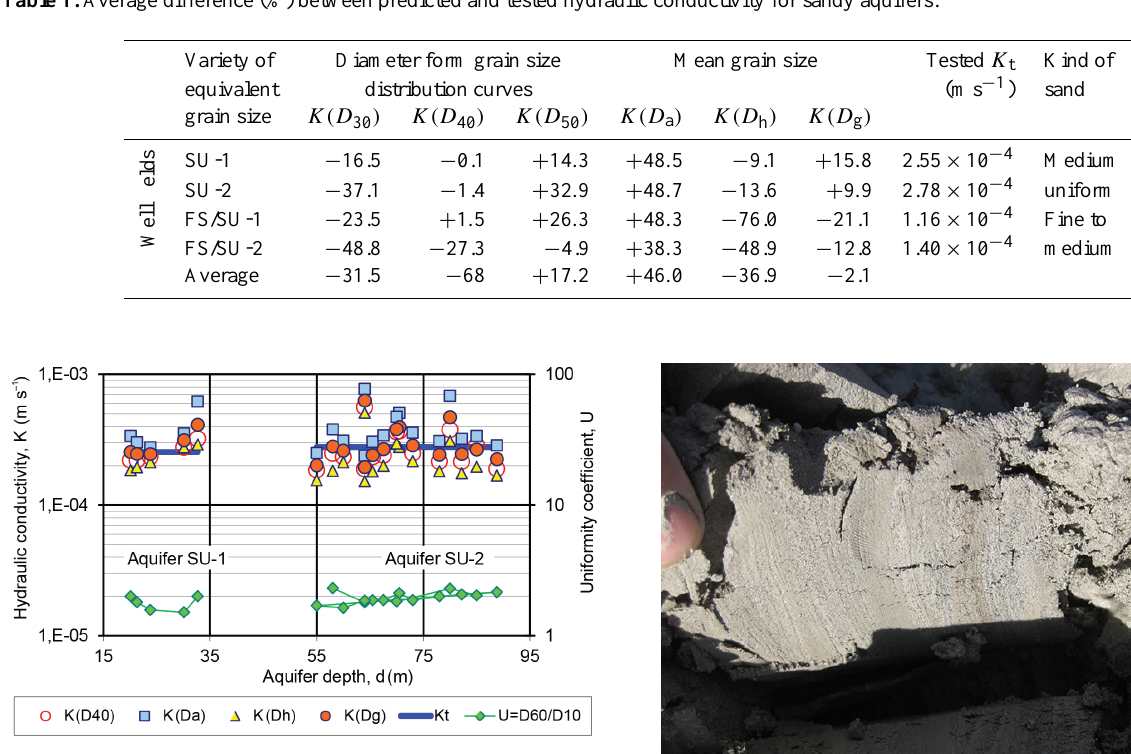
Figure 6. Predicted hydraulic conductivity calculated using the KC equation for samples from uniform sandy aquifer ( K(D 40 ) – K cal- culated using effective grain size D 40 ; K( D a ) – K calculated using arithmetic mean grain size; K(D h ) – K calculated using harmonic mean grain size; K(D g ) – K calculated using geometric mean grain size; Kt – tested hydraulic conductivity).